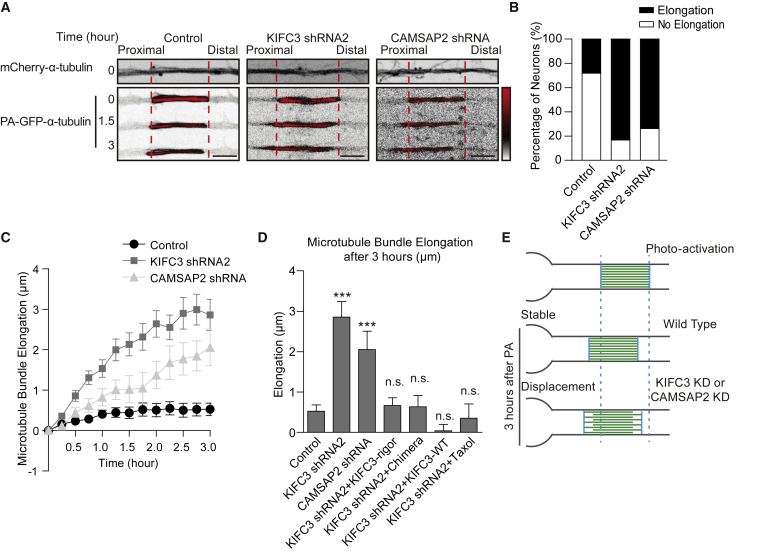
Dendritic Microtubules Become More Dynamic with KIFC3 or CAMSAP2 Depletion(A) Representative images of dendrites of hippocampal neurons DIV12 transfected with mCherry-α-tubulin, photoactivated GFP-α-tubulin together with pSuper-scrambled control, KIFC3 shRNA2, or CAMSAP2 shRNA (Video S3). Time is indicated at the left of each image. PA-GFP channel was indicated in black and red, and LUT was shown from the right. Red dash lines indicate the photoactivated microtubule region. Scale bars, 5 μm.(B) Quantification of the percentage of the neurons described in (A), in which the photoconverted region elongated.(C) Quantification of microtubule bundle elongation. Other measurements were shown in Figures S3D–S3J. Control: N = 5, n = 36; KIFC3 shRNA2: N = 4, n = 35; CAMSAP2 shRNA: N = 2, n = 15. Error bars, SEM.(D) Quantification of microtubule bundle elongation 3 h after photo-conversion corresponding to (A) and (C). KIFC3 shRNA2+KIFC3-rigor: N = 2, n = 20; KIFC3 shRNA2+KIFC3-Chimera: N = 3, n = 10; KIFC3 shRNA2+KIFC3-WT: N = 3, n = 12; KIFC3 shRNA2+Taxol: N = 3, n = 8. Error bars, SEM. Columns were compared with control. ∗p < 0.05; ∗∗p < 0.01; ∗∗∗p < 0.001 (unpaired t test).(E) Schematic graph of microtubule displacement in (A).